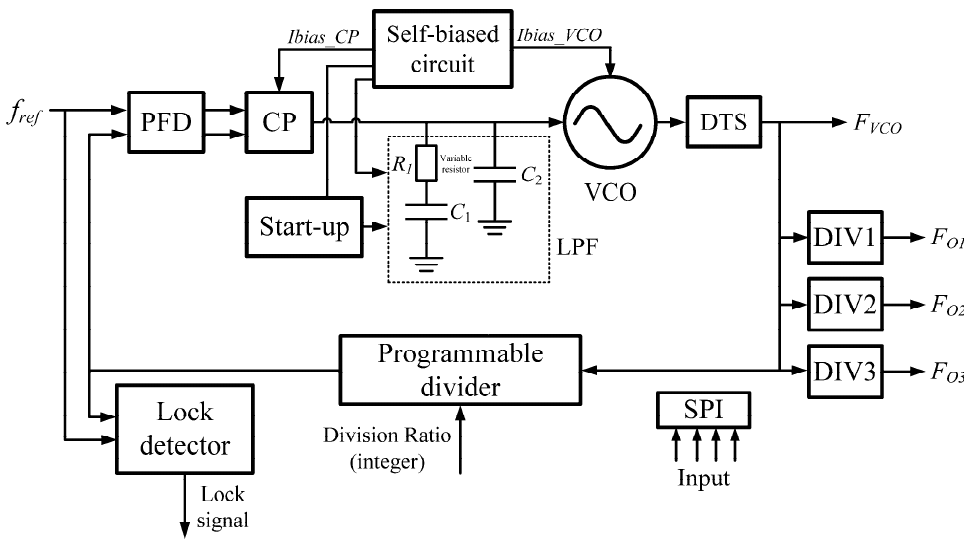
Figure 2. The proposed self-biased PLL.